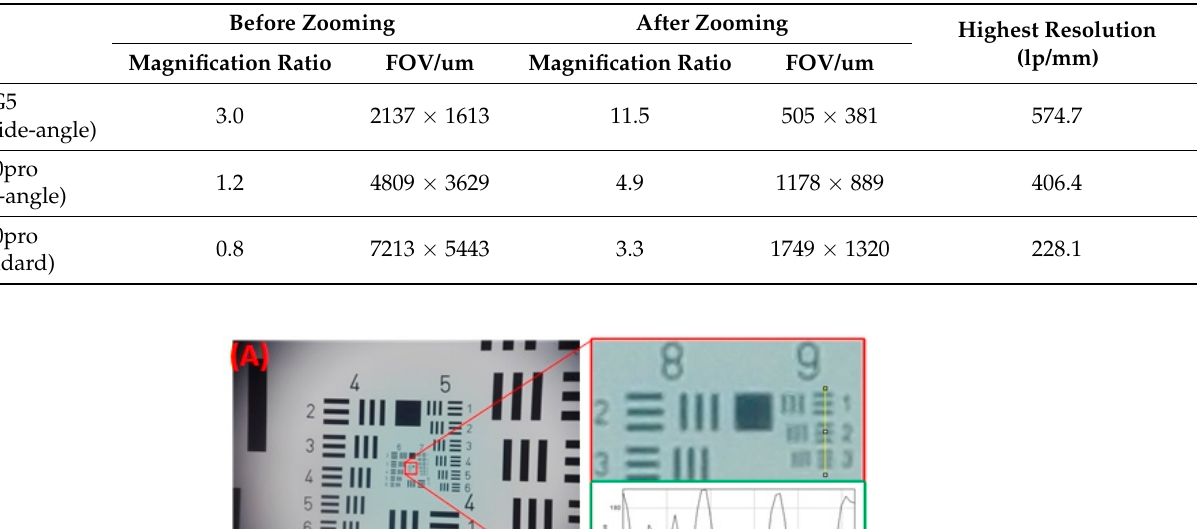
Table 2. Measurement result of the magnification ratio, FOV and resolution.